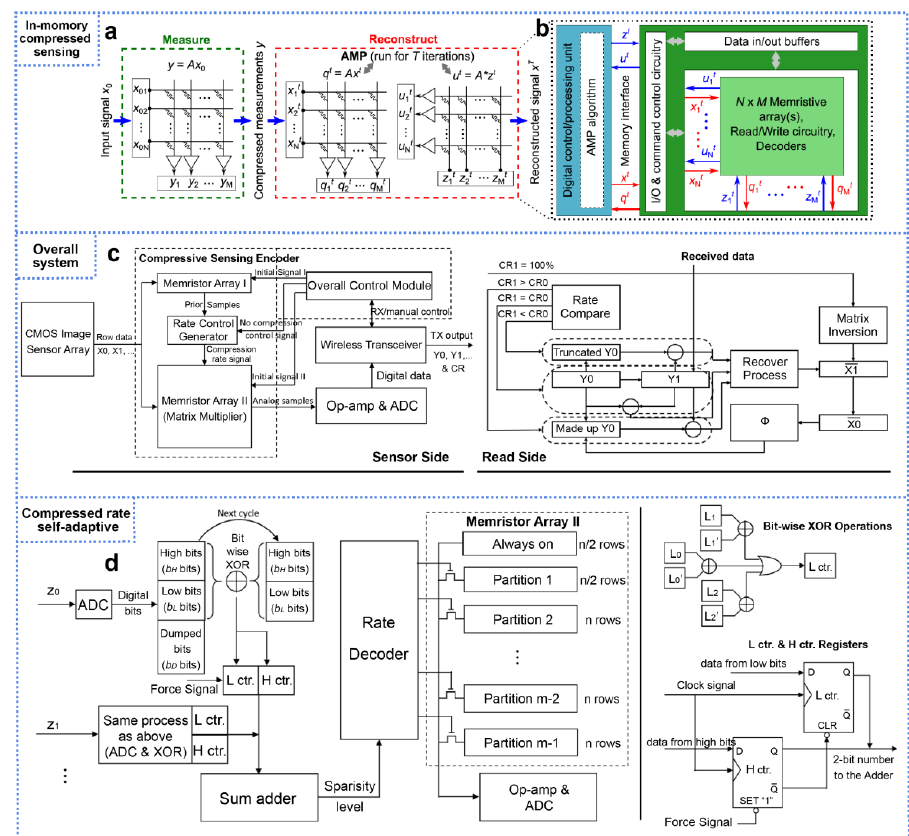
Figure 9. Non-volatile memristors for compressed sensing. ( a ) The N × M memristive crossbar encodes the measurement matrix A, which is used to obtain the CS measurements and implement the MVM of the AMP recovery algorithm. ( b ) Architecture of the memristive implementation of